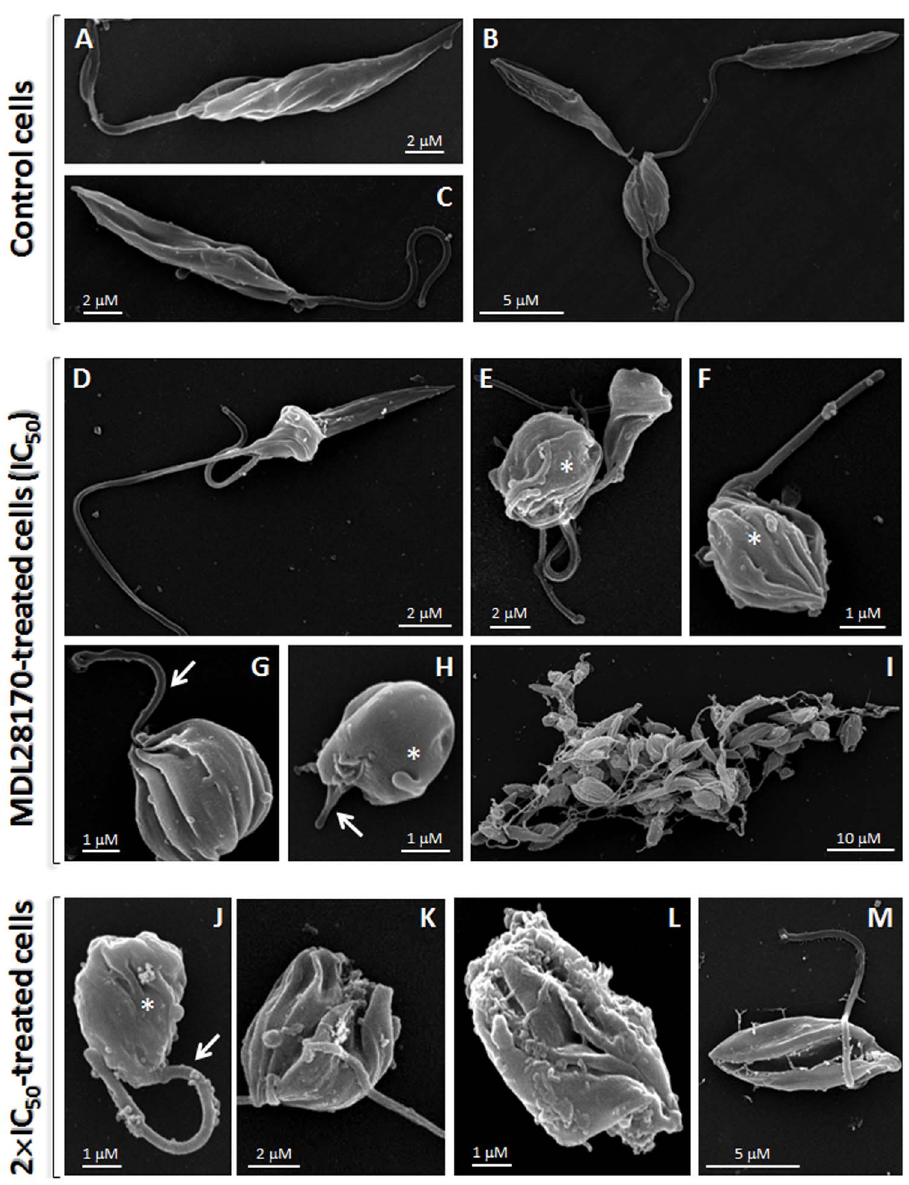
Figure 2. Scanning electron microscopy of Leishmaniaamazonensis promastigotes after treatment with MDL28170. In untreated, control promastigotes (A–C), note the elongated body and emerging flagellum. (D–I) Treatment with the IC 50 dose (D–I) and two times the IC 50 (2 6 IC 50 ) dose (J–M) of MDL28170 for 72 h caused shortening of the parasite body (E–H,J) and of the flagellum (arrows), membrane protrusions and ruffling of the plasma membrane (asterisks), appearance of cells with bizarre shape (D,K–M) and aggregation of cells